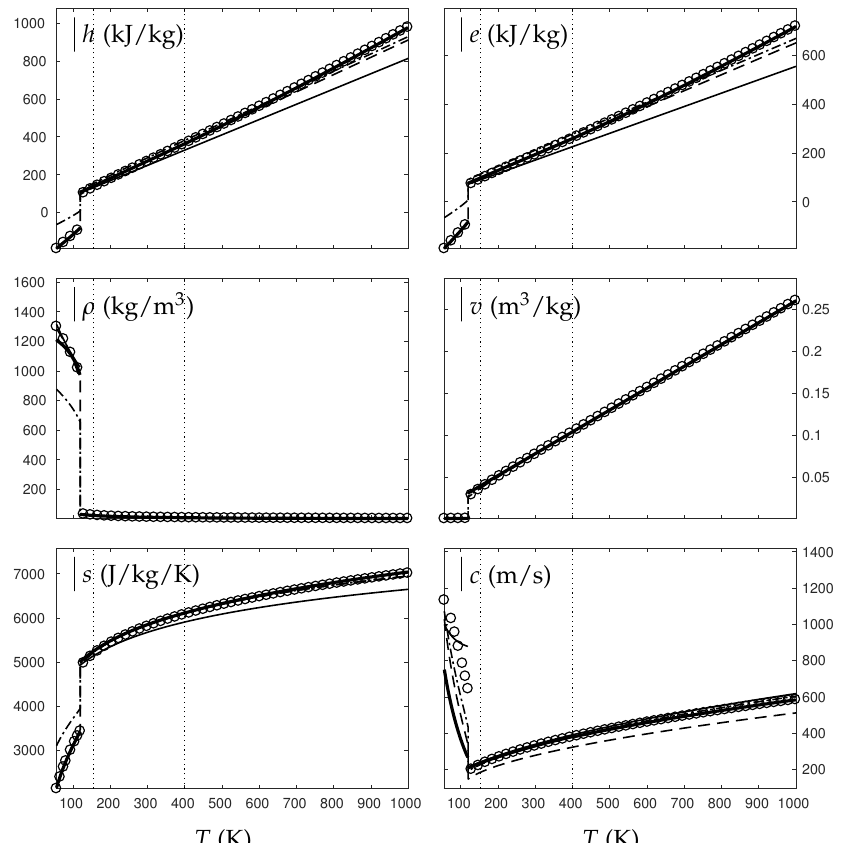
Figure 9. Comparison between experimental and theoretical isobar for oxygen. The symbols represent the experimental isobar p = 10 bars. Beyond the critical temperature T c = 154 K, the vapor transforms to supercritical state. The thick solid lines represent the Extended NASG (ENASG) EOS, reducing to the ideal gas description for vapor and supercritical phases, Equations (56), (57) and (60). The thin solid lines represent the original NASG EOS also reducing to the ideal gas formulation. The dashed-dotted lines represent the van der Waals (VdW) theoretical predictions and the dashed lines represent the Soave–Redlich–Kwong (SRK) ones. The critical temperature is indicated with the dotted lines. The temperature T 0 = 400 K at which variable heat capacities are considered is indicated in dotted lines as well.